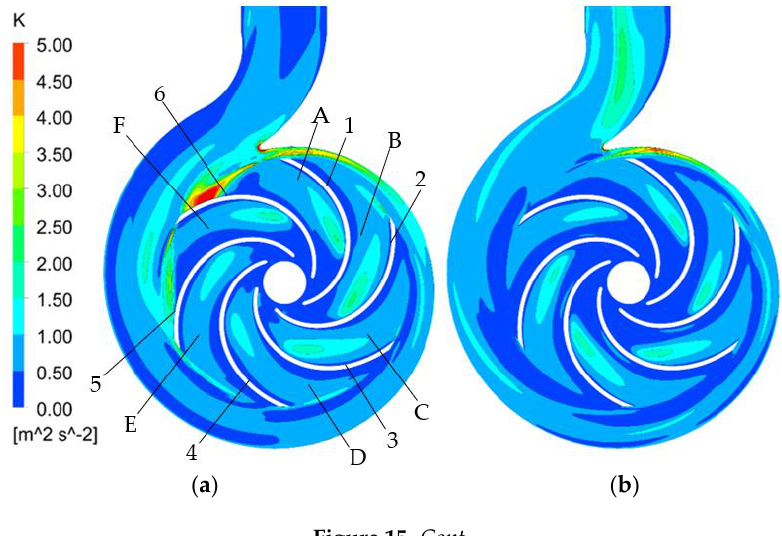
Figure 14. Water velocity distribution in axial plane b at extreme part load conditions. ( a ) 0.2 Q d , ( b ) 0.4 Q d